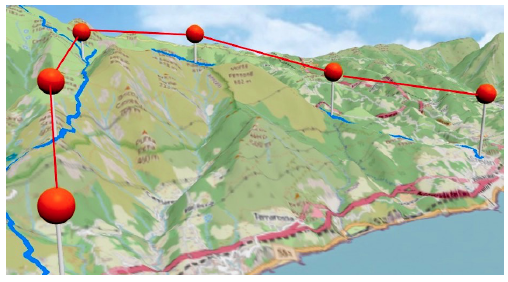
Figure 2. Example of an altimetric graph.